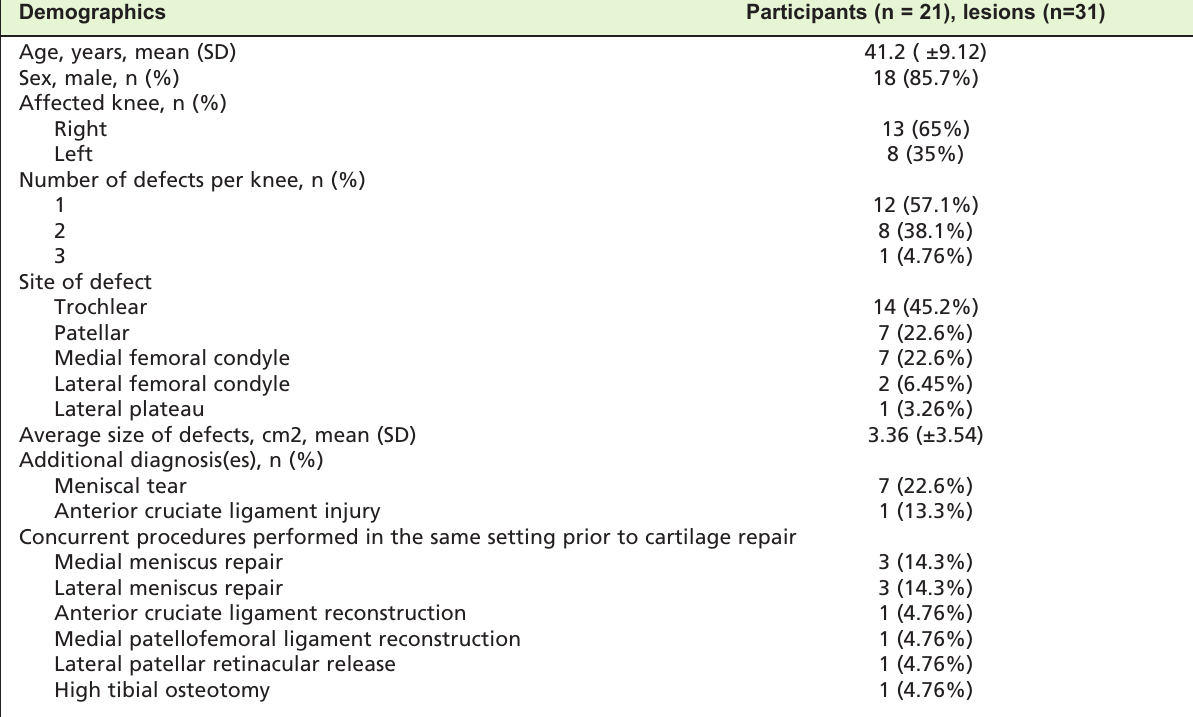
Table I: Demographics of study population and characteristics of lesions